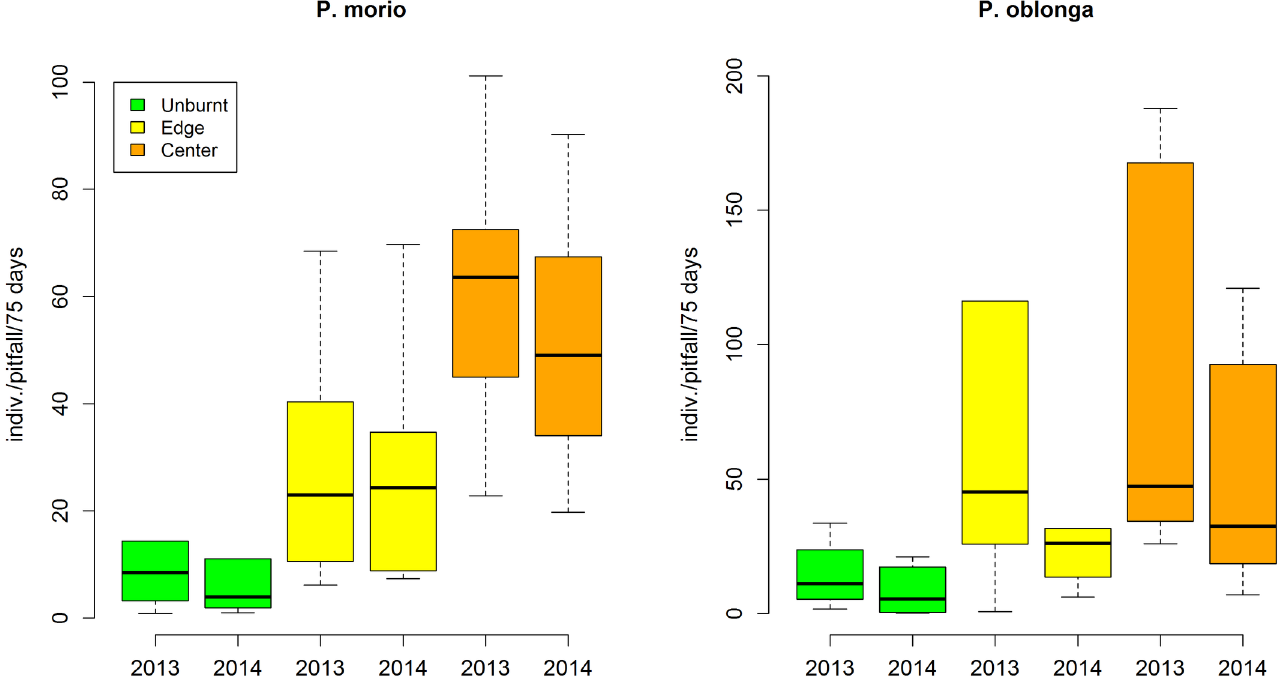
Fig 3. Abundance of Protaetiamorio (left) and P . oblonga (right). Values are mean number of individuals accumulated in a pitfall in 75 days for the years 2013 and 2014 in the unburnt area (green), in the burnt area close to the limit with the unburnt area (Edge; yellow) and in the burnt area far from the fire perimeter or from large unburned patches (Centre; orange). Variability is represented by the median (horizontal line), the quartiles (boxes) and the 1.5 times interquartile range (whiskers), and includes between plots and between fires. The number of plots (for each year) is 6, 6 and 12, for Unburnt, Edge and Centre, respectively. See Table 2 for the statistical analysis, and S4 Fig for the data split by the two burnt